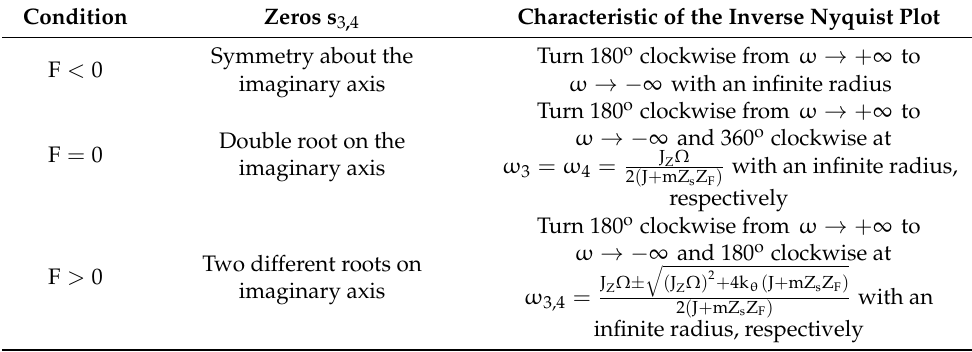
Table 1. Characteristics of the inverse Nyquist